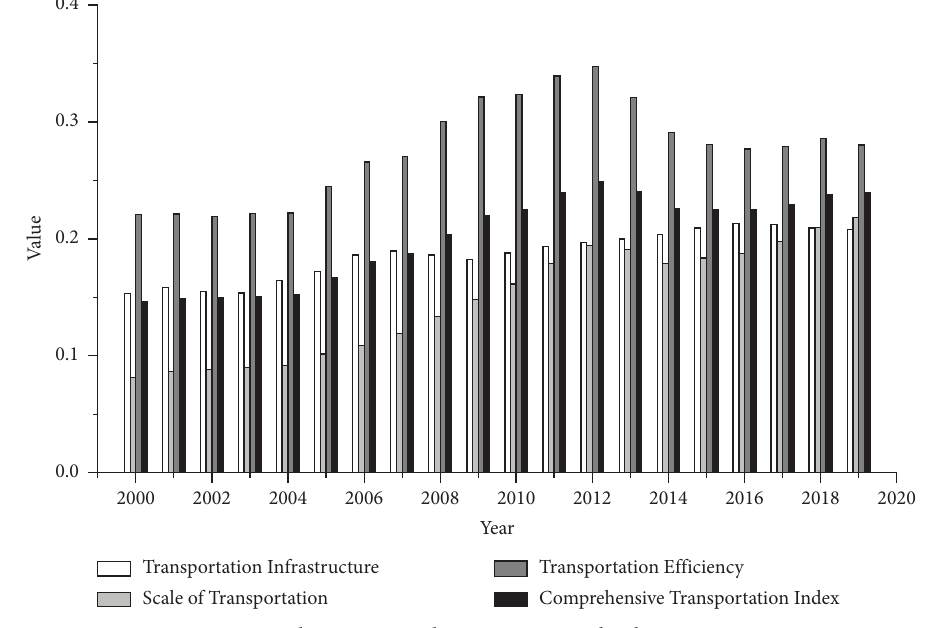
Figure 1: Chinese comprehensive transport level, 2000–2019.